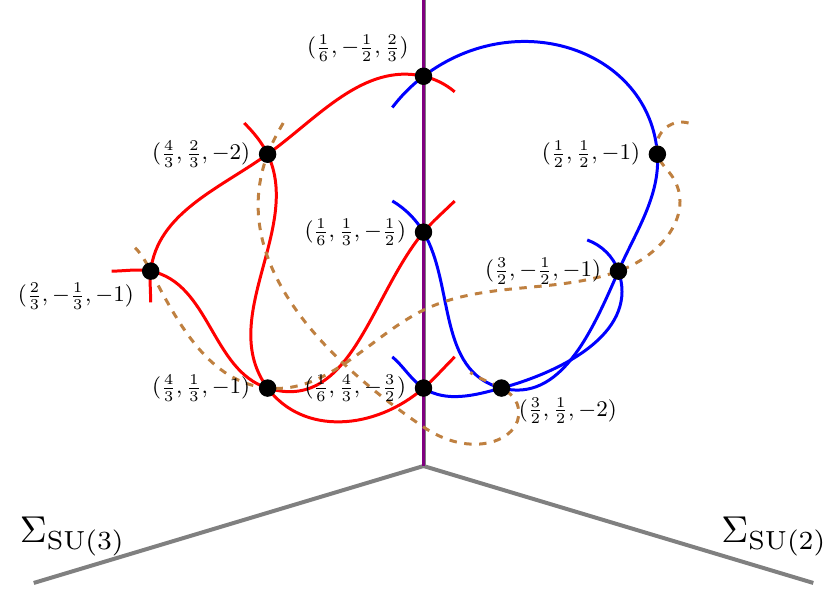
Figure 7 . Cartoon depiction of the various junctions of triples of matter curves C R , C R 0 , C R 00 ∈ B associated to candidate Yukawa interactions appearing in the low-energy 4D N = 1 action. Each codimension-three point in B in the above figure (represented by a black dot) is labeled by the triple of u (1) charges w of the three representations r , r 0 , r 00 (see eq. (6.4)) contracted into 0 , w 00 ¯1 , w ¯1 ¯1 a gauge singlet term in the low-energy Lagrangian; note that each triple labels one of a pair of possible complex conjugate interaction terms. The red, blue, and purple curves correspond to matter curves associated to non-trivial su (3) , su (2) , and su (3) ⊕ su (2) representations, respectively. By contrast, the dashed lines denote matter curves corresponding to pure u (1) charges. Note also that the ( 1 , 1 ) matter curve intersects the ( 1 , 2 ) in a tangent − 1 1 / 2